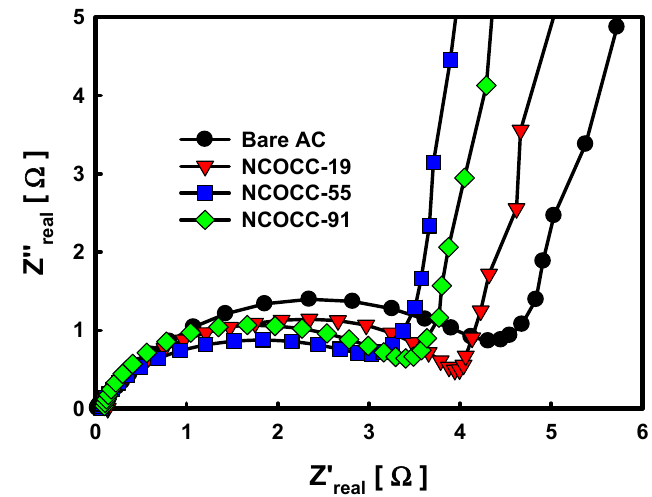
Figure 6. Electrochemical impedance spectroscopy (Nyquist plots) of NCOCCs electrode prepared by PiLP with di ff erent precursor combinations.